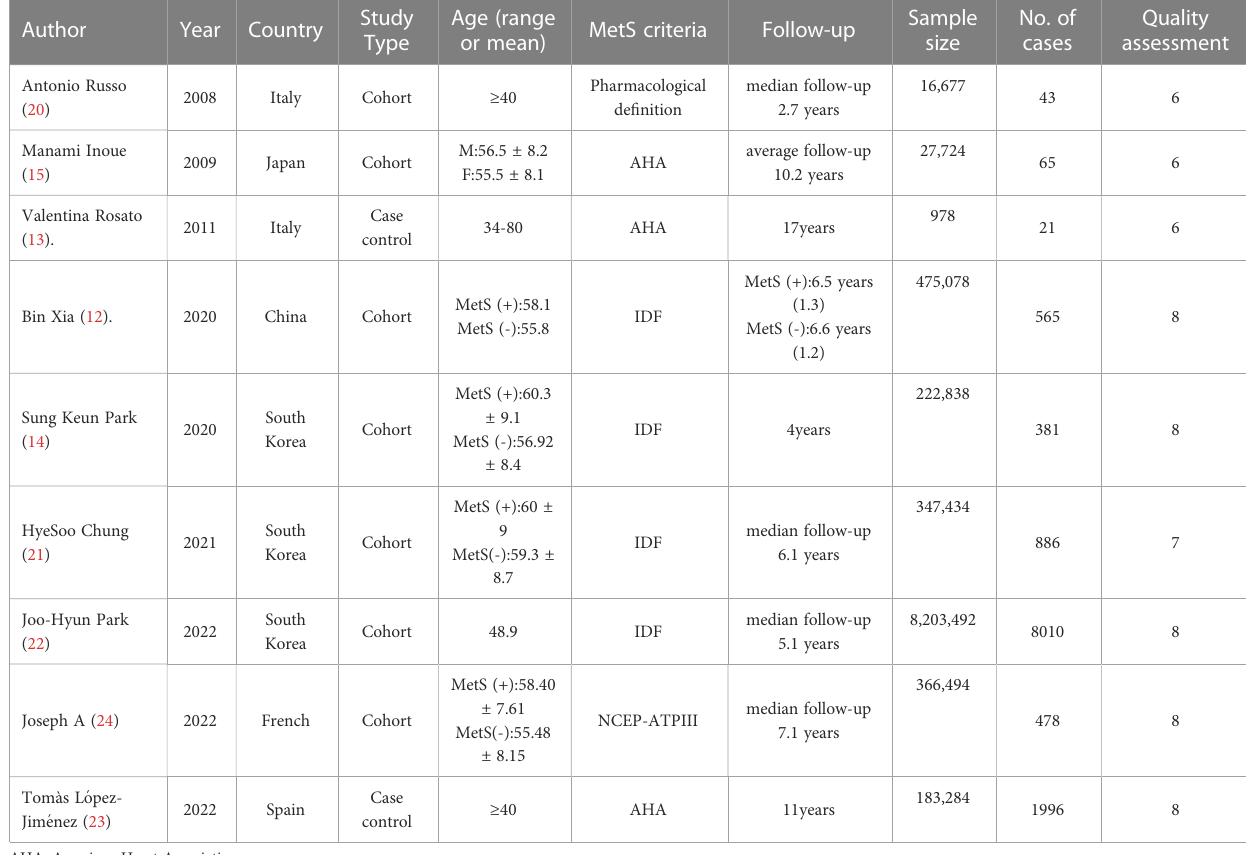
Valentina Rosato (13).